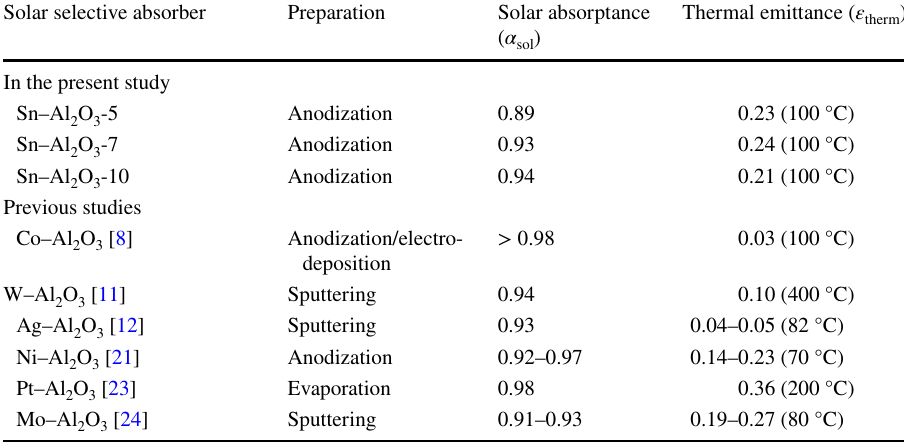
Solar selective